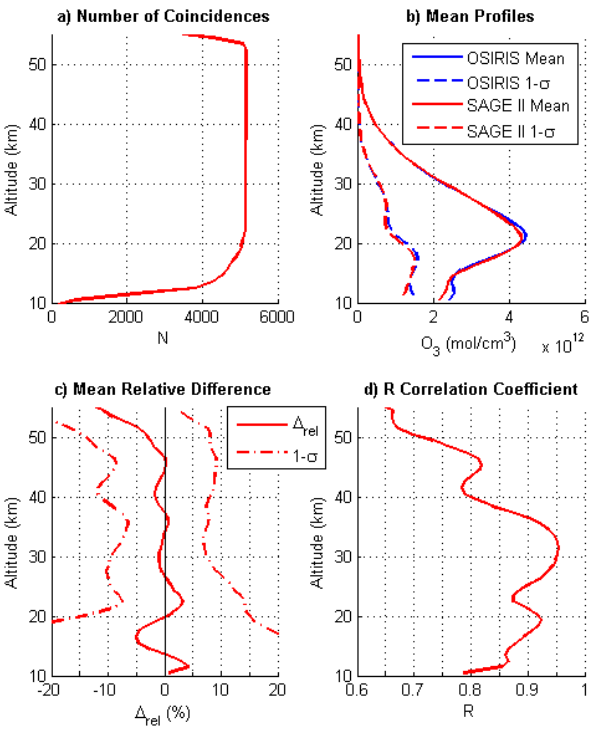
Fig. 4. As for Fig. 3 for broad coincidence criteria (see Table Figure 4: As for Fig. 3 for broad coincidence criteria (see Table 1). 2